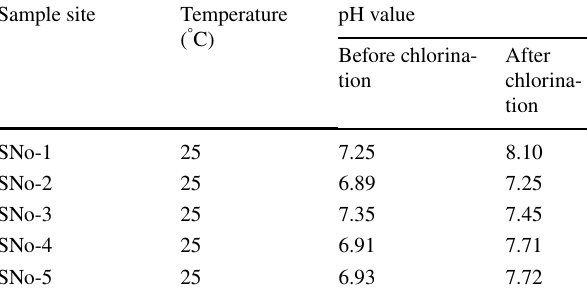
Table 2 pH value for samples before and after